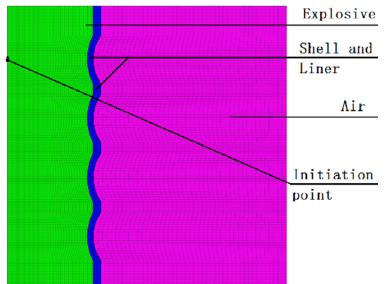
Figure 3. Finite-element model of integral circumferential MEFP warhead.